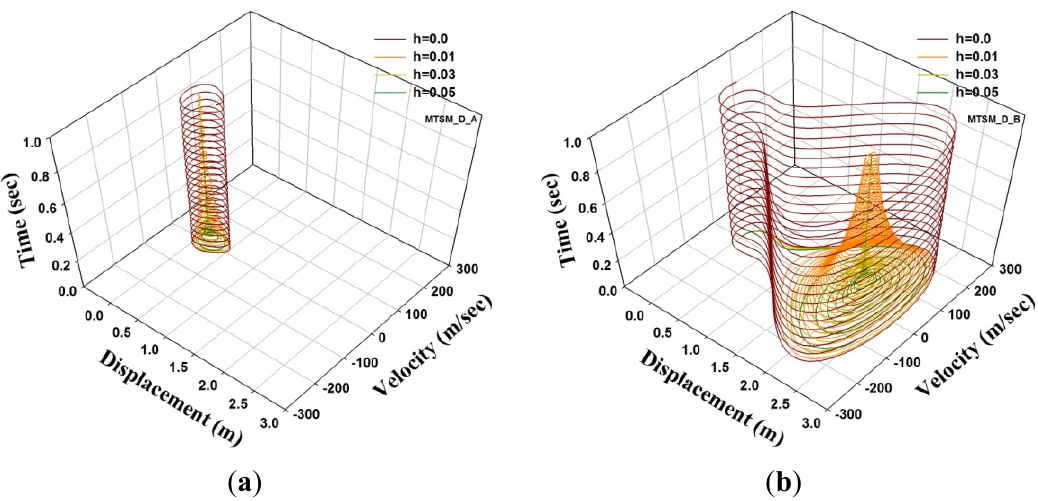
Figure 5. Phase space of a damped SFN model under a step excitation ( μ (cid:3404) 0.1 ): ( a ) Extended phase diagram, (cid:1832)